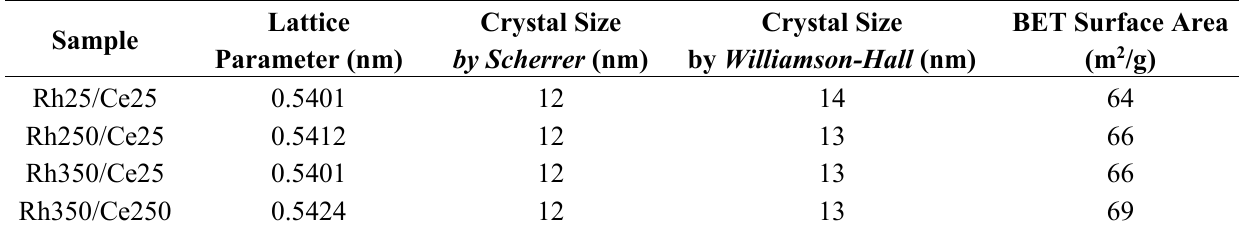
Table 1. XRD and N 2 adsorption characterization results.